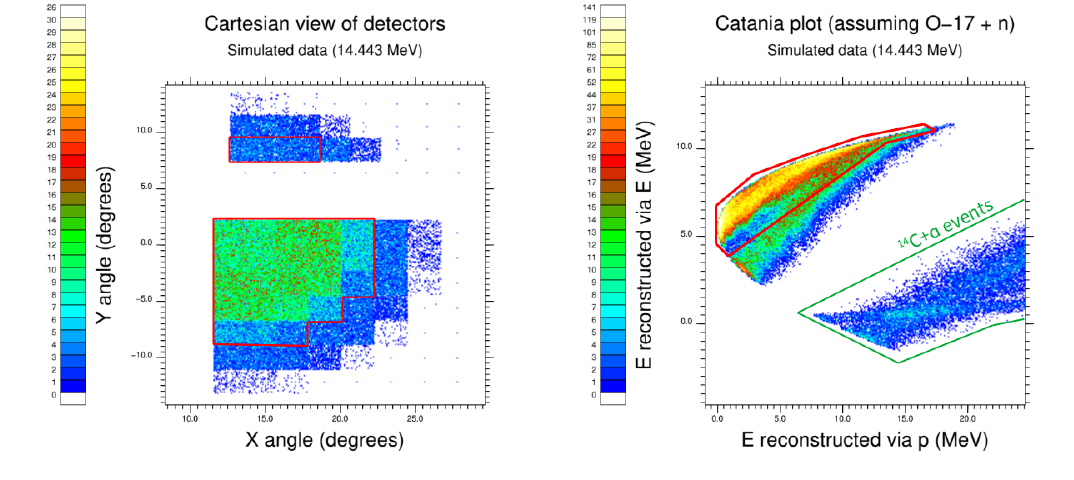
Figure 5: A view of the hit positions of charged particles on the DSSD array (left) and a Catania plot generated assuming measured products arise from a n -decay of 18 O ∗ (right), both generated using Monte Carlo data for ( 18 O ∗ , n ) and ( 18 O ∗ ,2 n ). The regions highlighted in red represent areas within which > 99.5% of ( 18 O ∗ ,2 n ) events are located.